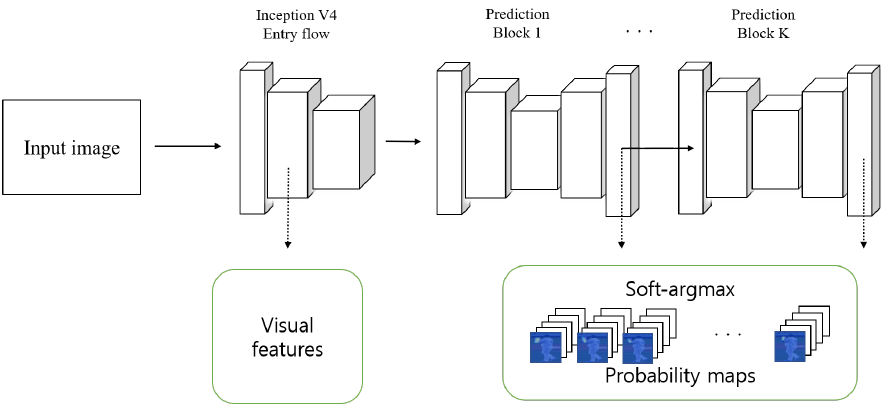
Figure 7. Visual feature and probability map extraction algorithm through Inception V4. Human pose regression approach from a video frame. The input video is fed through a CNN composed by one entry flow and K prediction blocks. Predictions are refined at each prediction block.